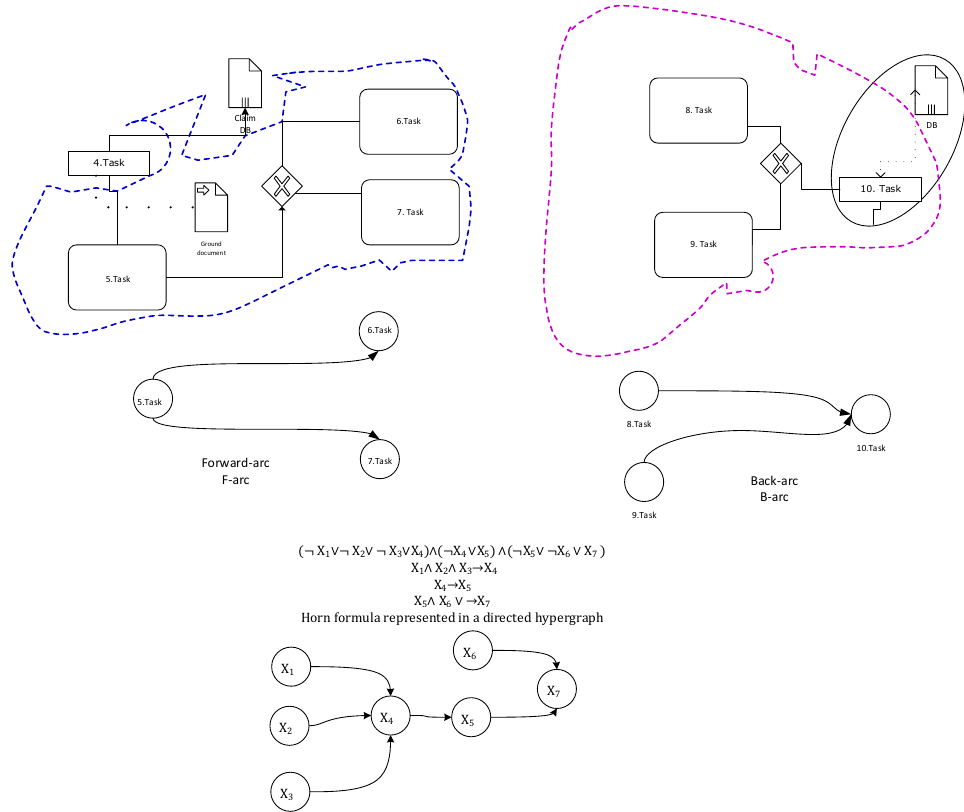
Figure 16. Workflow fragments and their relationships with the transformed B-arc and F-arc. Option 6. ∃ i , [ D ] ij = d ij = 1 and the meta-attribute “valuated” of all variables in